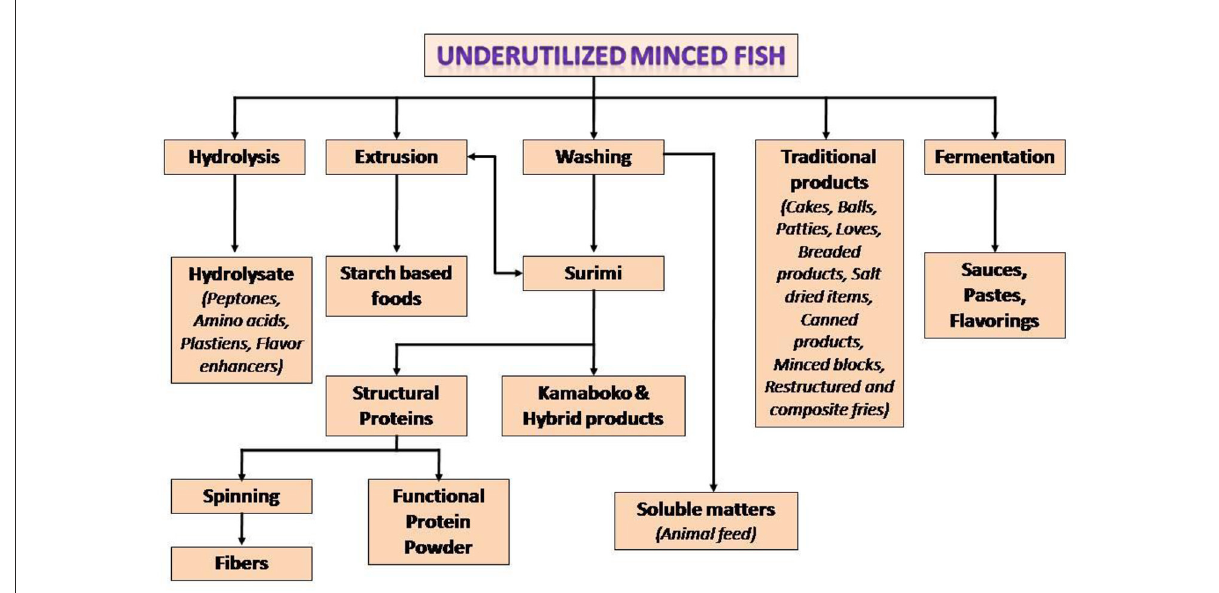
FIGURE1 Potentials for various protein-rich products from bycatch meat. Source, Venugopal and Shahidi (33) with